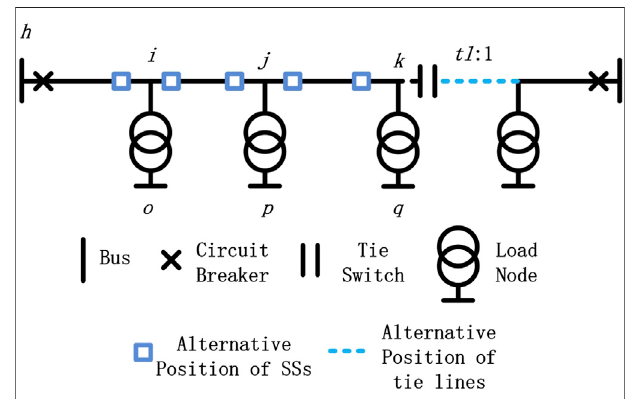
FIGURE 1 | An example of a distribution